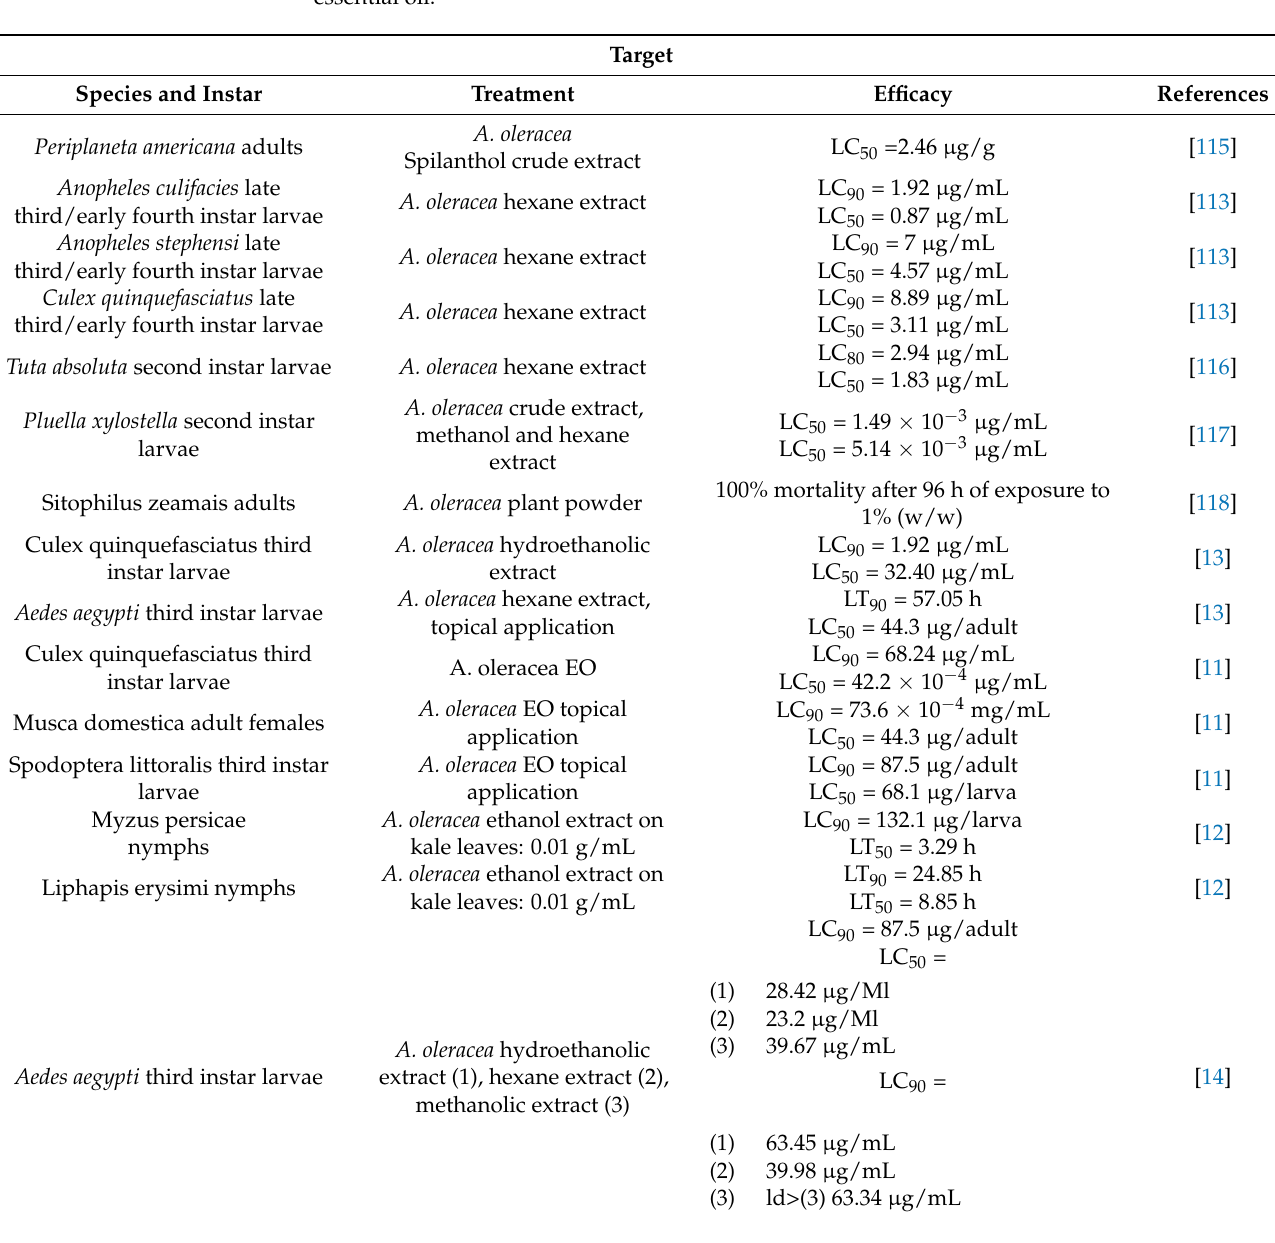
Table 3. Insecticidal activity of Acmella oleracea -borne products on insect pests and vectors. EO: essential